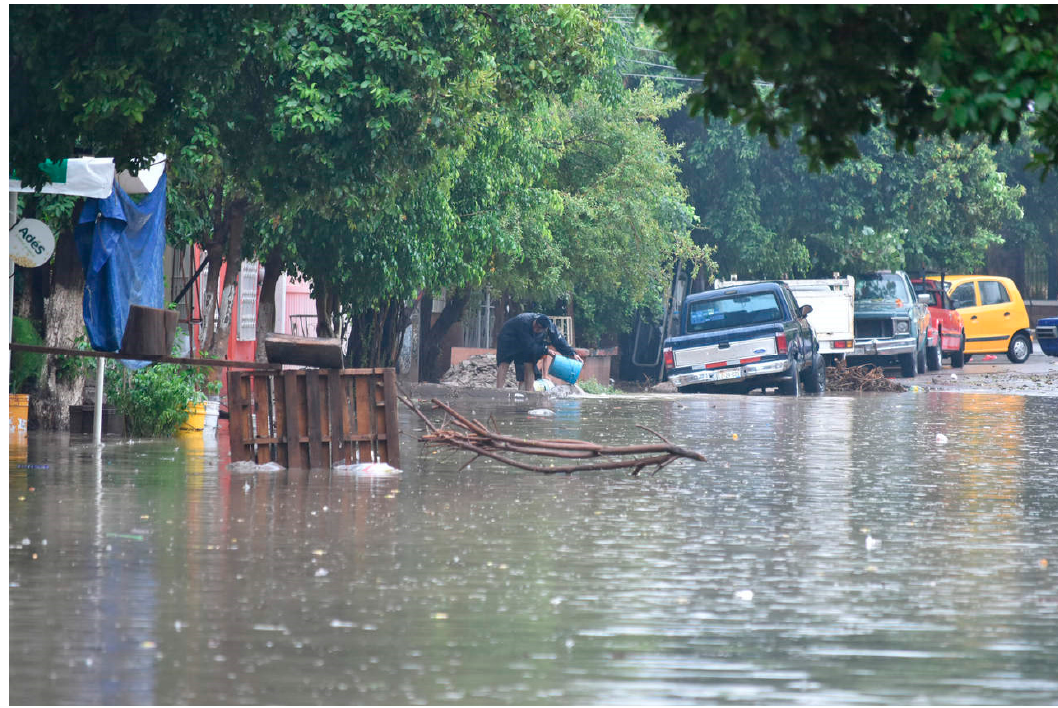
Figure 4. Floods in Torreón, 28th of September 2018 (El Siglo de Torreón).